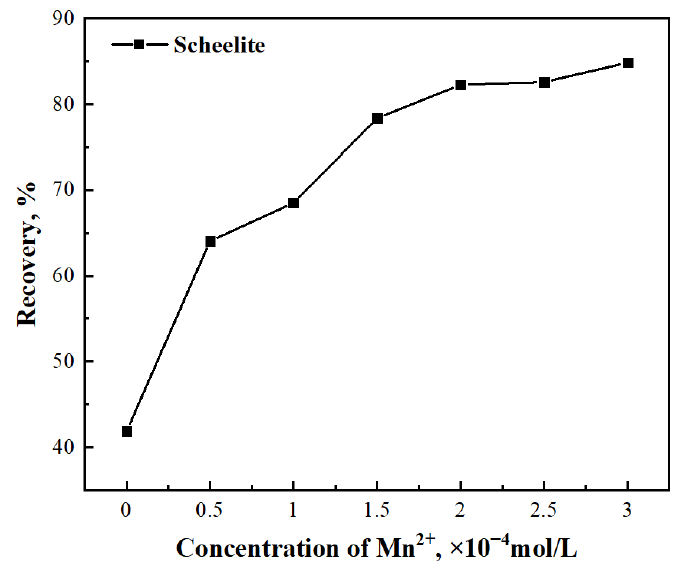
Figure 3. Effect of Mn 2+ concentration on the recovery of scheelite flotation.